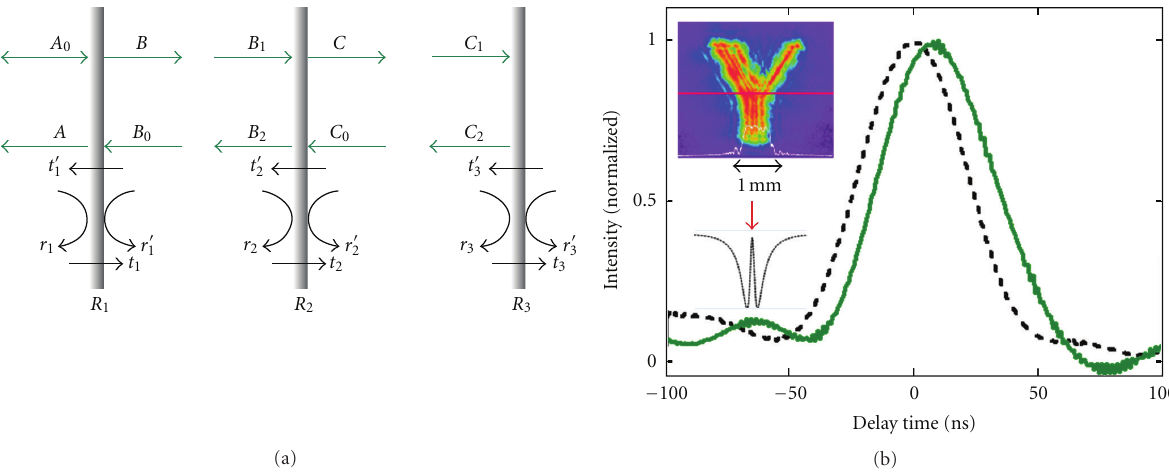
Figure 1: (a) Schematic illustration of the reflected and transmitted image propagation through a coupled Fabry-Perot image resonator. In this figure, R 1 , R 2 , and R 3 are the reflectivities of the three mirrors that comprise the coupled cavity. (b) An example of delayed pulsed 2D image propagation through the coupled-resonator-induced transparency. The insets show the reflected image (top) at the center of the transparency window (CRIT), indicated by the red arrow in the frequency spectrum